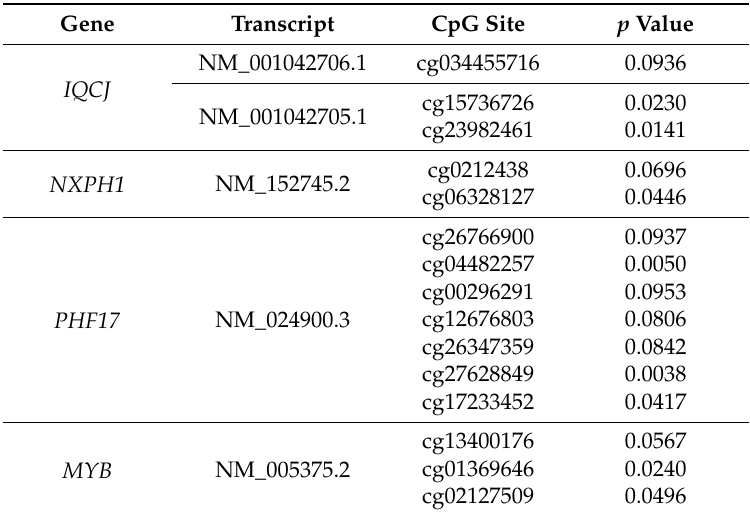
Table 5. Marginal and significant correlations between transcript expression and DNA methylation levels ( n = 29 individuals).